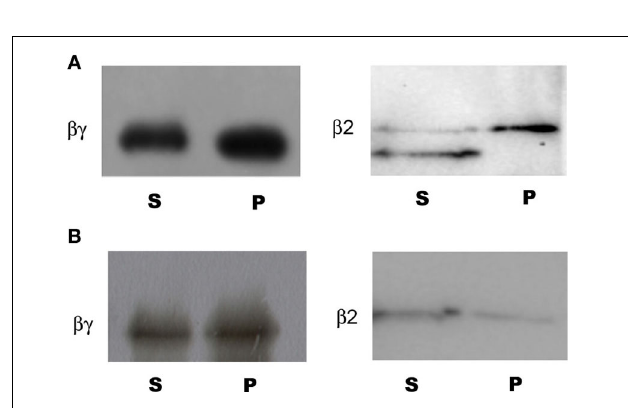
FIGURE 2 | Binding of AKIN βγ and AKIN β 2 to starch and A/A. Samples of each protein were incubated with starch and A/A as described in the Materials and Methods section. The carbohydrate-protein complexes were collected by centrifugation and samples of the soluble fraction (S) and bound fraction (P) were separated by SDS-PAGE, and Western blot analysis was performed using protein-specific antibodies. (A) Protein-starch complexes. (B) Protein-A/A